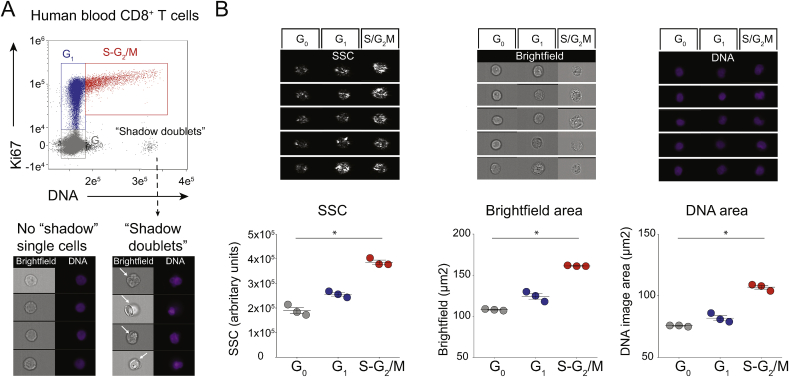
Human blood CD8+ T cells have increased signal for SSC and DNA as they progress through the cell cycle.CD3+CD8+ cells from HD PBMC were analysed by ImageStream. A) DNA/Ki67 plot (top), showing “no shadow” single cells in G0 (grey), G1 (blue) and S-G2/M (red), with assigned colour codes adopted in all subsequent analyses, and Ki67(−)Hoechsthi “shadow doublets”. Brightfield and DNA images showing “no shadow” single cells (bottom left) and “shadow doublets” (arrows, bottom right). B) Examples (top) and summary of results (lower, N = 3 HD) for median SSC intensity (arbitrary units), Brightfield (μm2) and DNA Image Area (μm2) of single cells in G0, G1, and S-G2/M, gated as in A and Supplemental Fig. 3A, Step 1 to 6 (bottom, N = 2 experiments with a total of 3 HD). Statistical analysis performed using Friedman's test with Dunn's multiple comparison tests.